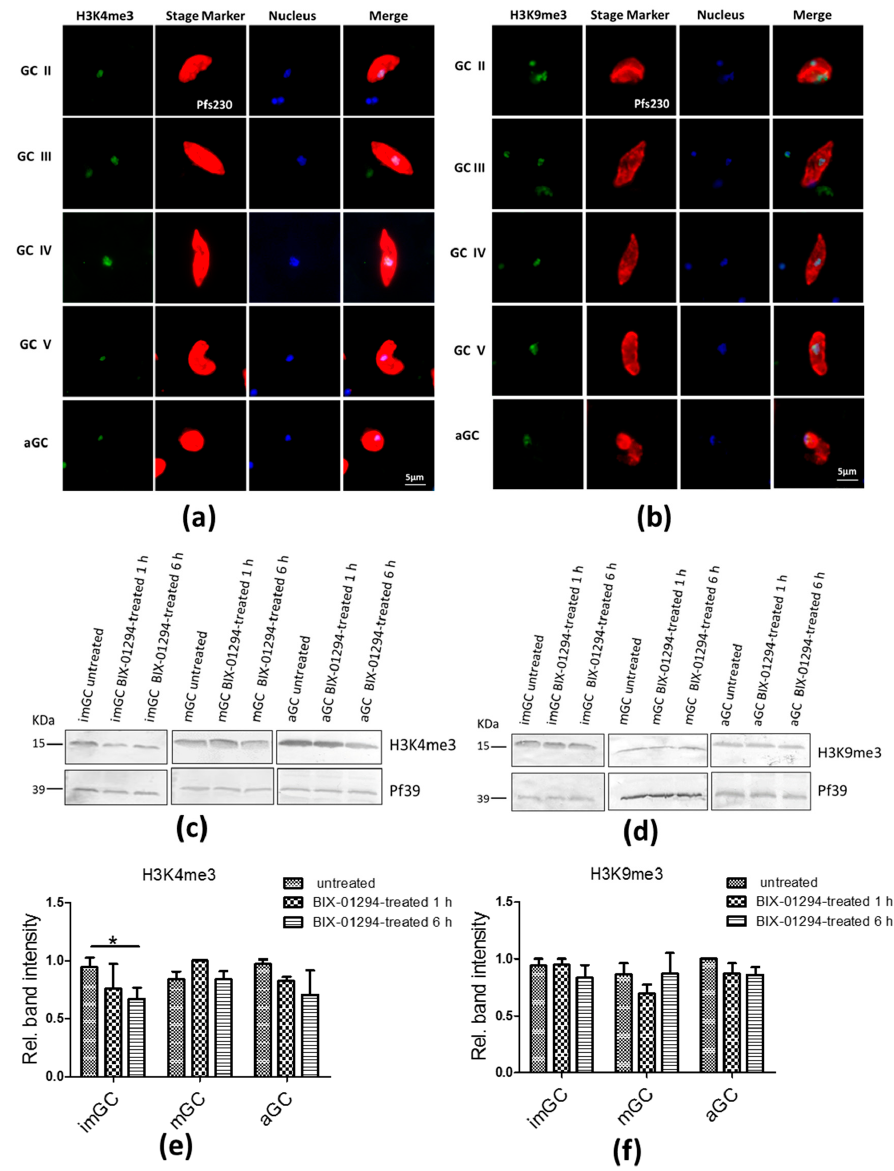
Figure 3. H3K4me3 and H3K9me3 levels following treatment of gametocytes with BIX-01294. ( a , b ) Detection of H3K4me3 and H3K9me3 marks in gametocytes by indirect immunofluorescence assays. Presence of H3K4me3 and H3K9me3 in gametocytes were detected in the different gametocyte stages (GC stage II-V) via immunolabelling using rabbit anti-H3K4me3 ( a ) and anti-H4K9me3 ( b ) (green). Gametocytes were highlighted with mouse antibodies against the gametocyte marker Pfs230 (red). Nuclei were highlighted by Hoechst nuclear stain 33342 (blue). Bar, 5 µ m. ( c , d ) detection of H3K4me3 ( c ) and H3K9me3 ( d ) in BIX-01294 treated and untreated gametocytes by Western blotting. Lysates of immature (imGC) and mature gametocytes (mGC) following treatment with BIX-01294 at IC 90 concentrations or 1% vol. DMSO (untreated) for 1 and 6 h at 37 °C were subjected to Western blot analysis using anti-H3K4me3 and anti-H3K9me3 antibodies; ( e , f ) quantification of H3K4me3 and H3K9me3 following BIX-01294 treatment of gametocytes. Histone methylation was quantified between BIX-01294 treated and untreated samples by measuring the band intensities following immunoblotting via ImageJ for three di ff erent experiments ( e , f ); values were normalized with band intensities of Pf39 used as loading control (set to 1). * p <